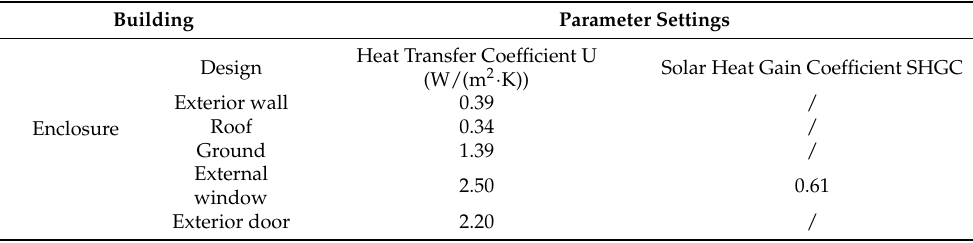
Table 5. Main envelope